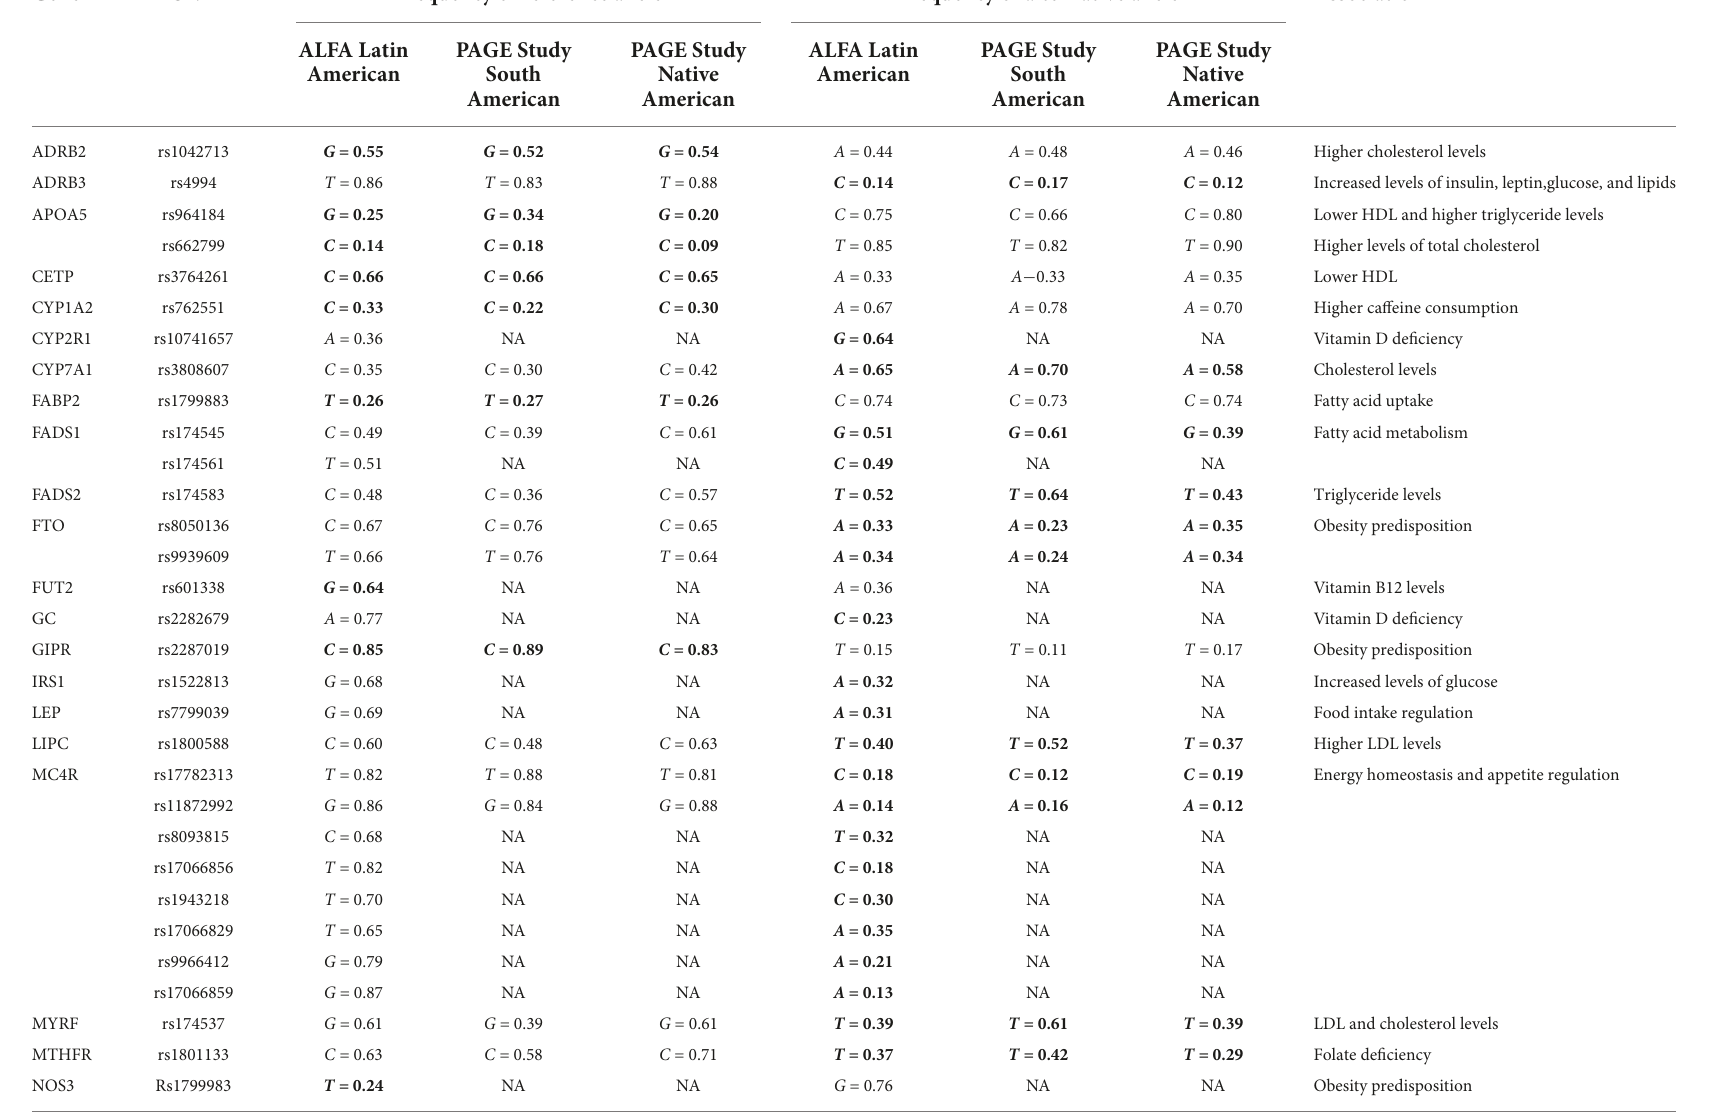
TABLE 1 Latin American frequencies of SNPs associated with obesity, including South and Native American.